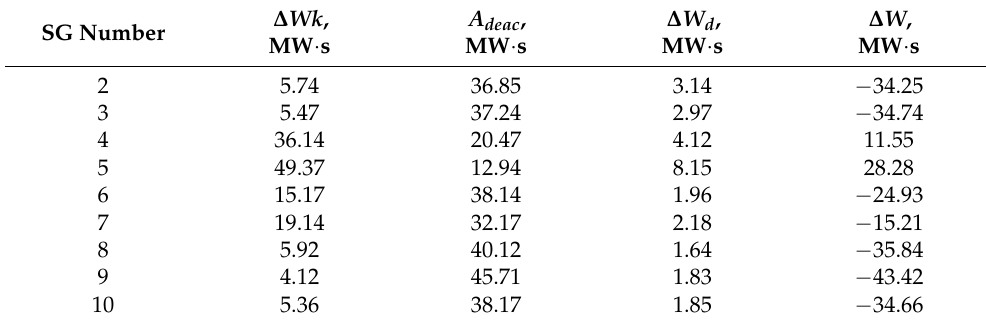
Table 3. Results of transient stability